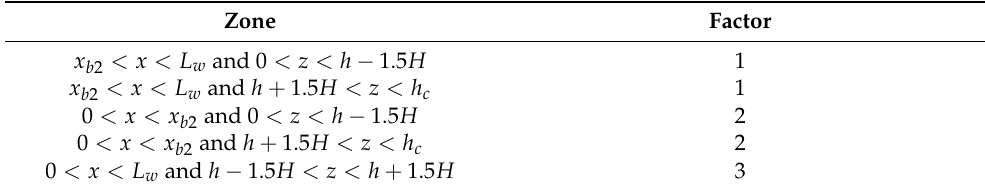
Table 2. Refinement factor used for as input for the OpenFOAM ® ’s function snappyHexMesh . Zone